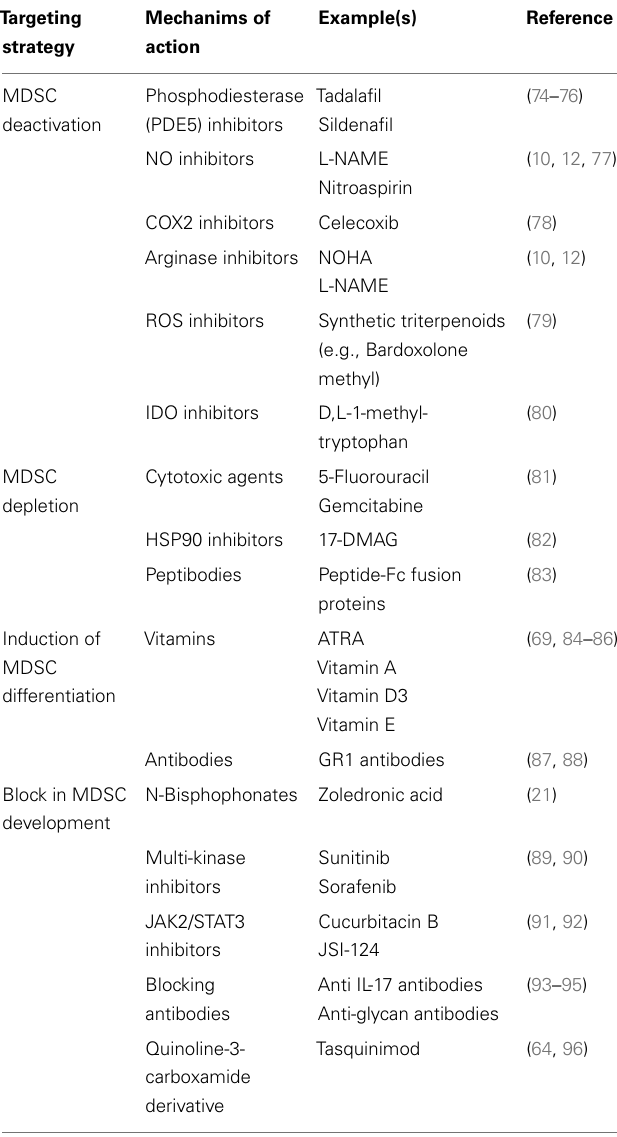
Table 2 | General overview of MDSC targeting agents